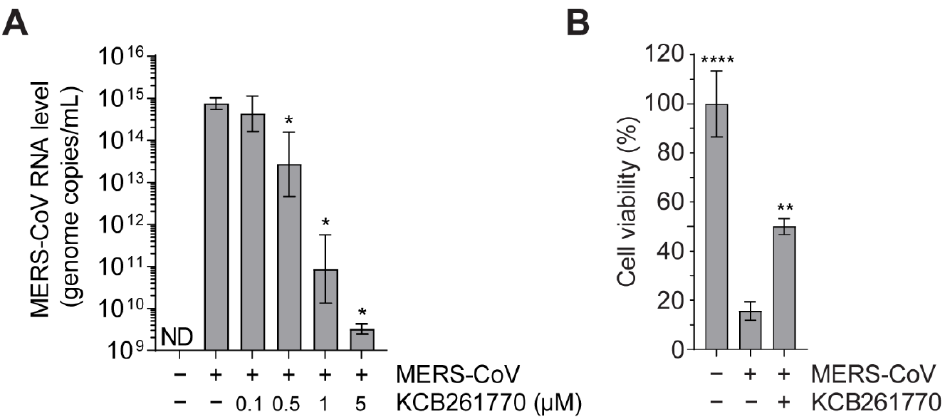
Figure 6. Suppression of MERS-CoV propagation by compound KCB261770. ( A ) Huh7 cells infected with 0.02 MOI of MERS-CoV were treated with increasing concentrations of compound KCB261770. At 2 dpi, genome copy number of MERS-CoV RNA in the media were determined by qRT-PCR using primers targeting MERS-CoV N gene. ND; not detected. ( B ) Cell viability was measured at 2 dpi with or without treatment of compound KCB261770 (5 µM). * p < 0.05, ** p < 0.01, **** p < 0.0001 vs. control (MERS-CoV-infected cells without treatment) (one-way ANOVA with Dunnett’s multiple comparisons test).